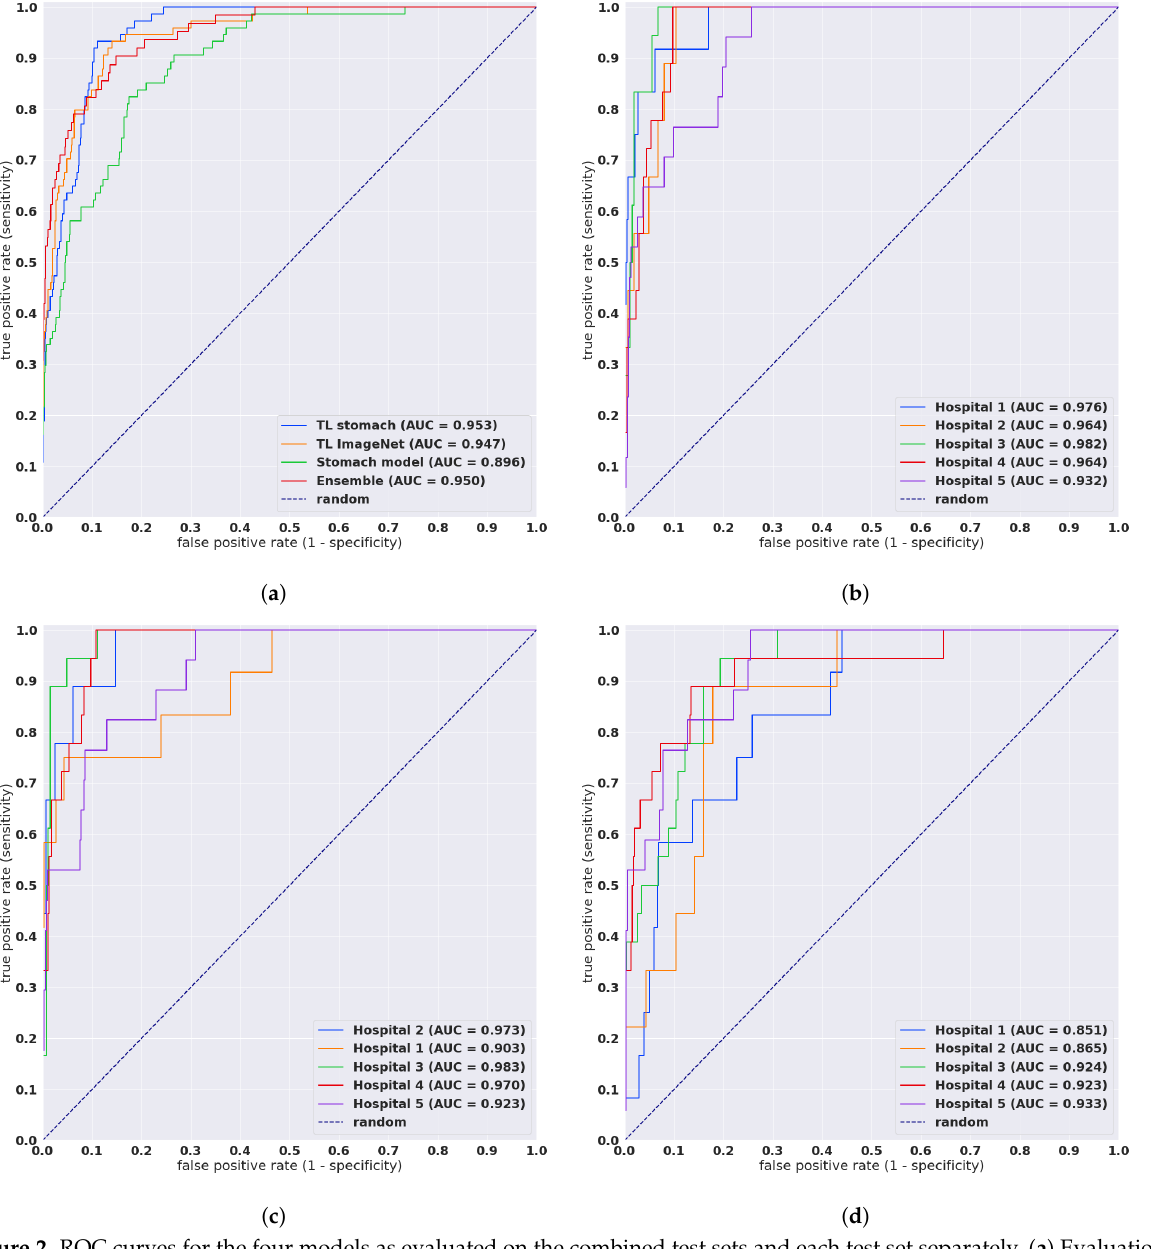
Figure 2. ROC curves for the four models as evaluated on the combined test sets and each test set separately. ( a ) Evaluation of the four models on the combined test set ( n = 1741), ( b ) TL stomach model on the test sets that had poorly differentiated ADC, ( c ) TL ImageNet model on the test sets that had poorly ADC, ( d ) Stomach model on the test sets that had poorly differentiated